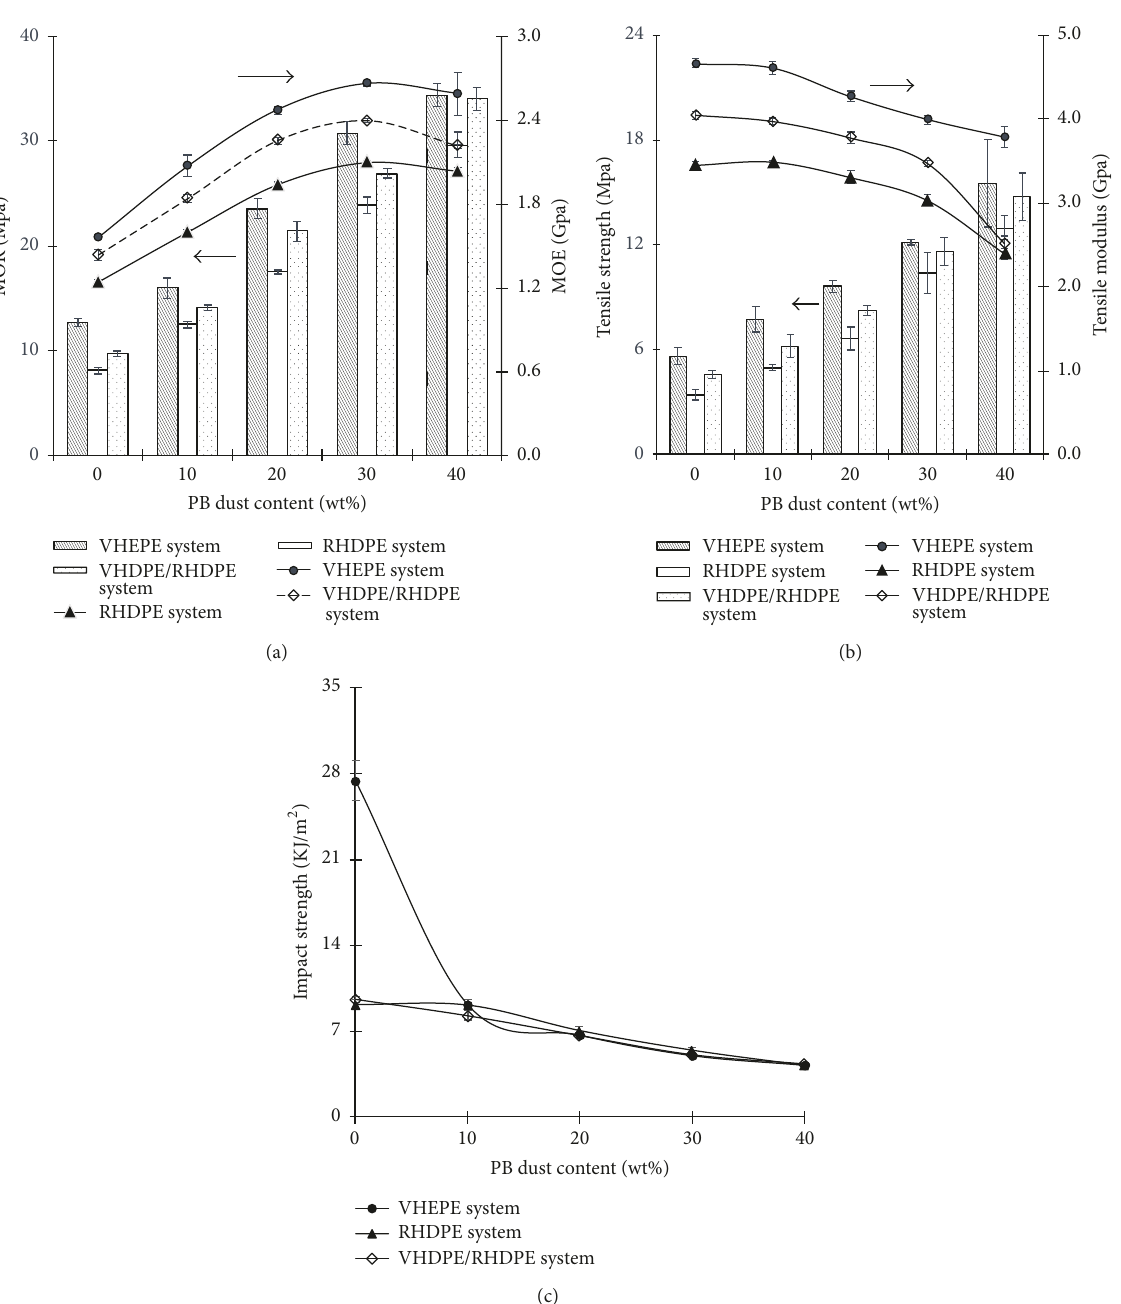
heating cycle ( − 30 to 20 ∘ C ) had the smallest LCTE, which suggested that the thermal expansion behavior of composite was related to the thermal history built into the